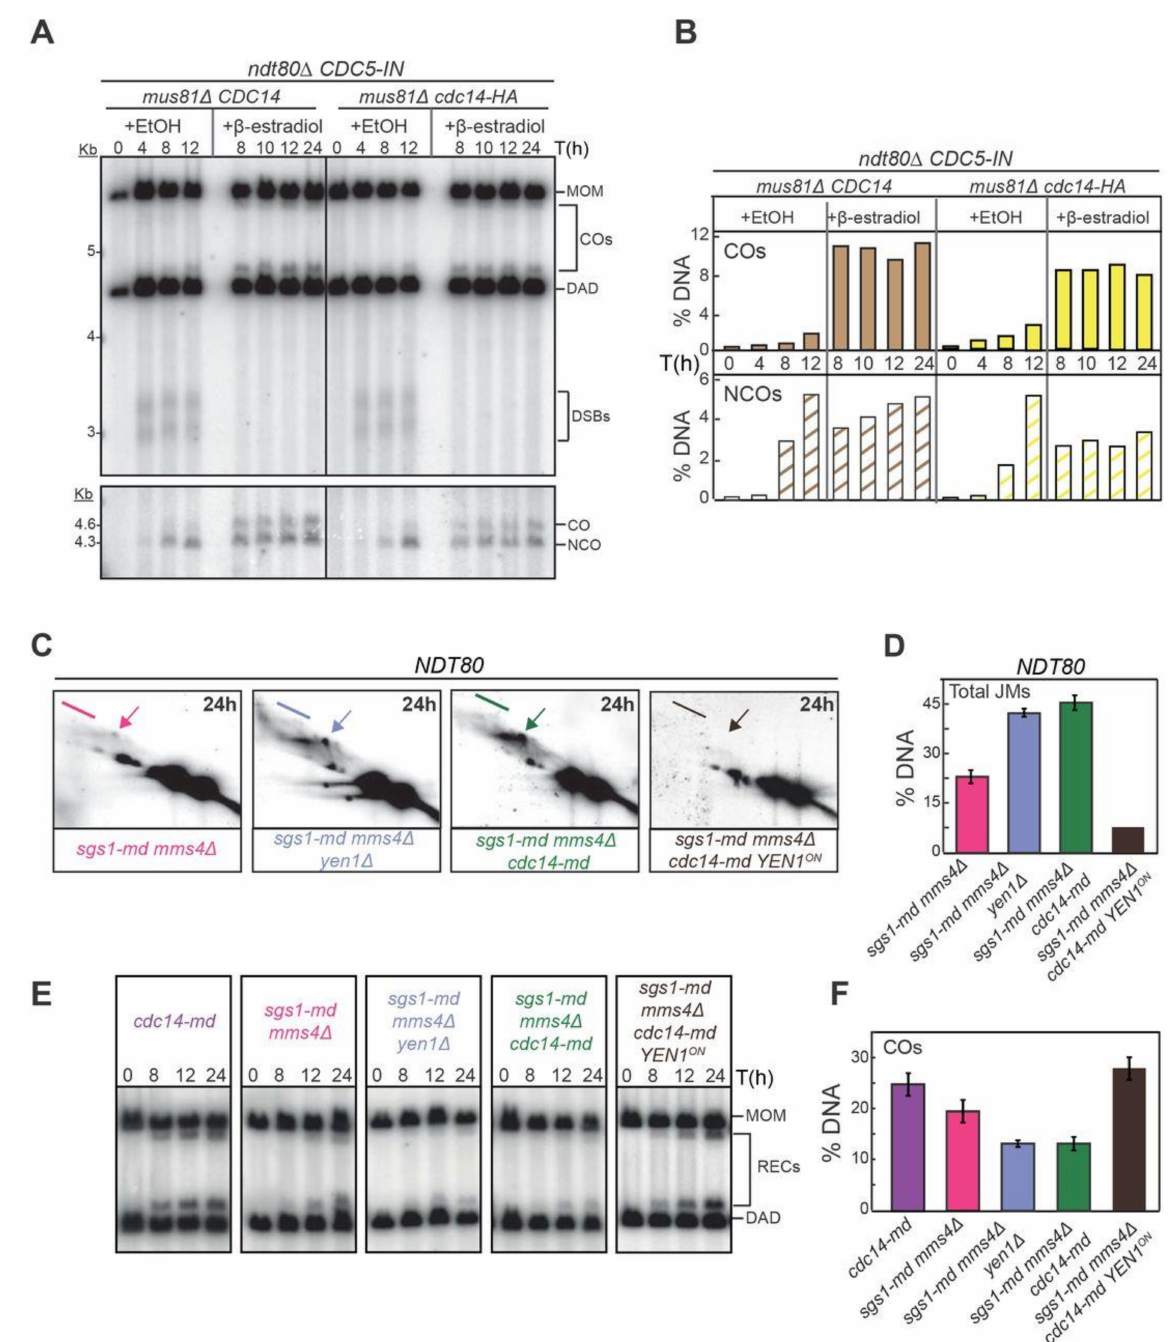
Figure 5. Analysis of recombination intermediates in cdc14 mutants shows early and late accumulation of JMs. ( A ) Representative Southern blots depicting 1D-gels at the HIS4LEU2 hotspot following induction of CDC5 in prophase- arrested ndt80 ∆ mus81 ∆ cdc14-HA cells (JCY2440) leads to inefficient CO and NCO formation compared to ndt80 ∆ mus81 ∆ (JCY2442). ( B ) Quantification of COs and NCOs from Southern blots shown in ( A ). ( C ) Representative Southern blots depicting 2D-gels at the HIS4LEU2 hotspot in sgs1-md mms4 ∆ (JCY2444), sgs1-md mms4 ∆ cdc14-md (JCY2446), sgs1-md mms4 ∆ yen1 ∆ (JCY2448) and sgs1-md mms4 ∆ cdc14-md YEN1 ON (JCY2529) 24 h into meiosis. Arrows mark IH-dHJs and lines mark mc-JMs (see Figure 4A,B). ( D ) Quantification of total JMs in the strains shown in ( C ) from at least two independent gels. Error bars represent SEM over the calculated mean value. ( E ) Representative 1D-gel Southern blot images for analysis of crossovers at the HIS4LEU2 hotspot for all strains shown in ( C ) and for cdc14-md (JCY2389). ( F ) Quantification of COs from at least three different image acquisitions such as that depicted in ( E ). Error bars represent SEM over the calculated mean